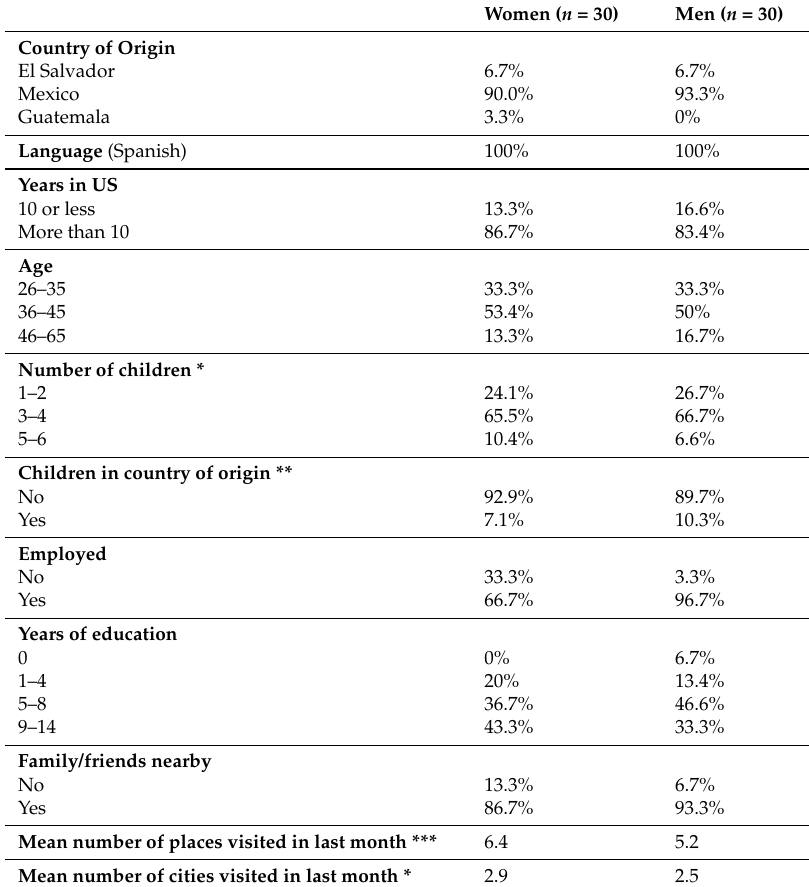
Table A1. Demographic summary of participants a .